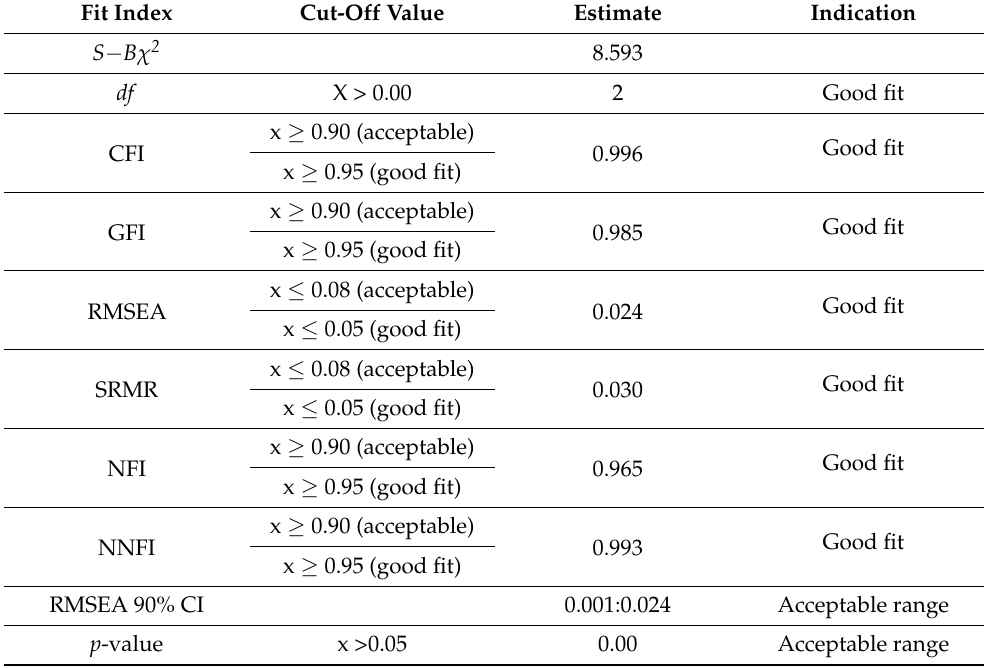
Table 6. Robust Fit Indexes for Performance Measurement